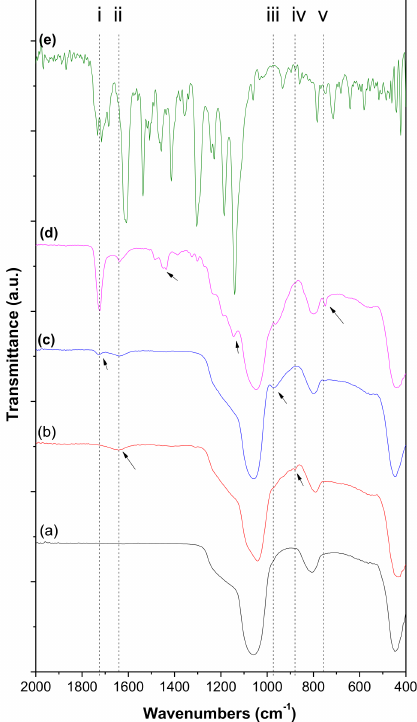
Figure 4. FTIR spectra of step-by-step modified samples for ( a ) mSiO 2 calcined at 550 ◦ C for 5 h;